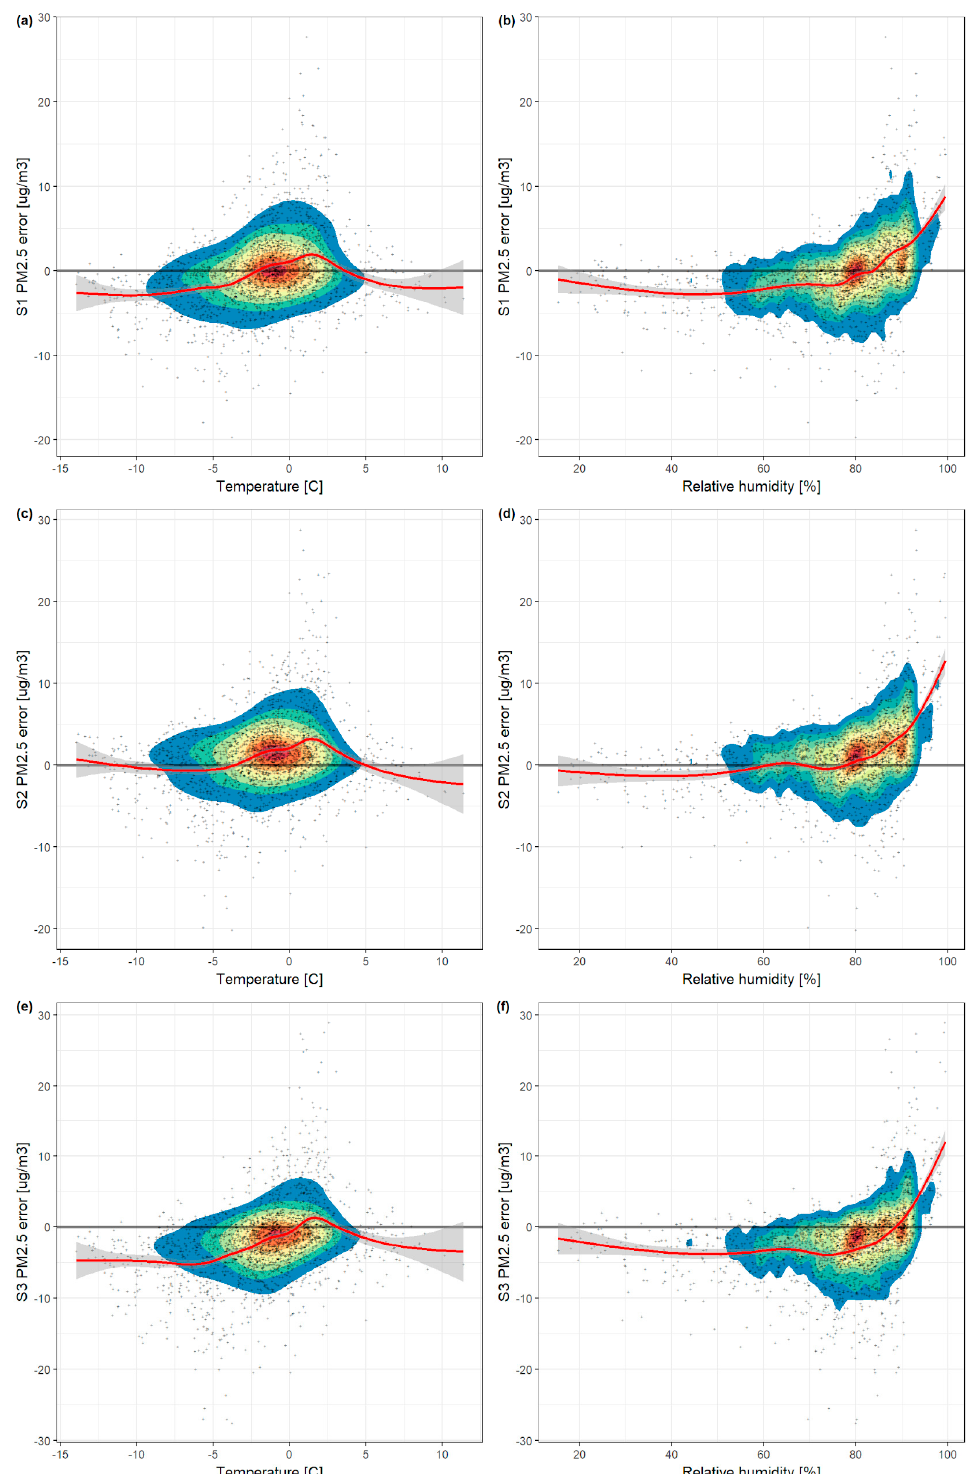
Figure 8. Relationship between observed PM 2.5 sensor error (measured as sensor observation minus reference data) and air temperature (left Panels ( a ), ( c ), ( e )) as well as relative humidity (right Panels ( b ), ( d ) and ( f )) for S1 (top row, Panels (a) and (b)), S2 (middle row, Panels (c) and (d)), and S3 (bottom row, Panels (e) and (f)). Black dots indicate the actual hourly average observations, whereas the coloured surfaces indicates the density of occurring observations, highlighting where the majority of observations are located. The red line represents a Loess fit to the dataset with the grey area indicating the 95 % confidence intervals.